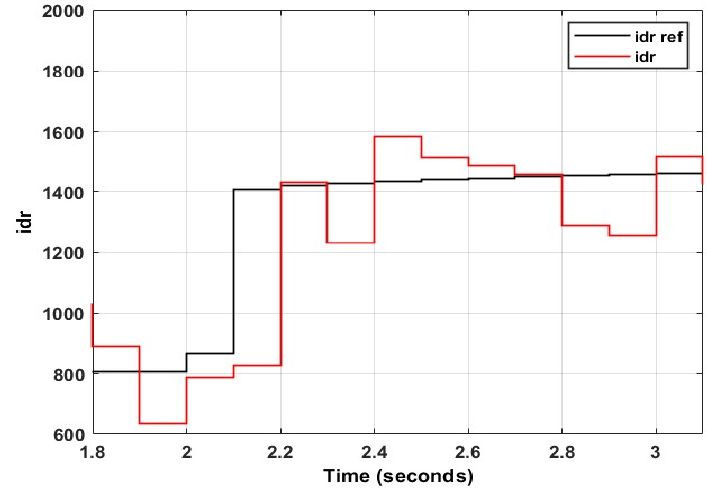
Figure 27. Rotor direct axis current ripple using DCI at 70% dip.